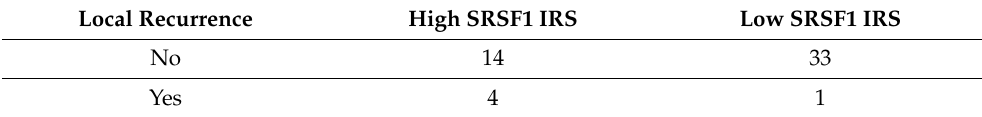
Table 2. Distribution of local recurrences according to SRSF1 immunoexpression.